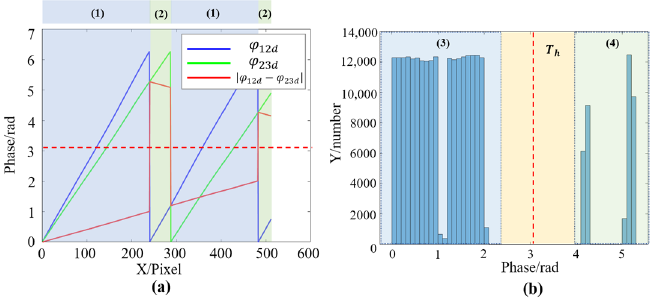
Figure 3. Phase difference calculation results. ( a ) Synthetic phases and the absolute values of their difference. ( b ) Histogram graph of the | ϕ 12 d − ϕ 23 d | , the red dotted line is the possible threshold T h   , the red dotted line is the possible threshold difference. ( b ) Histogram graph of the 12 23 d d T . h